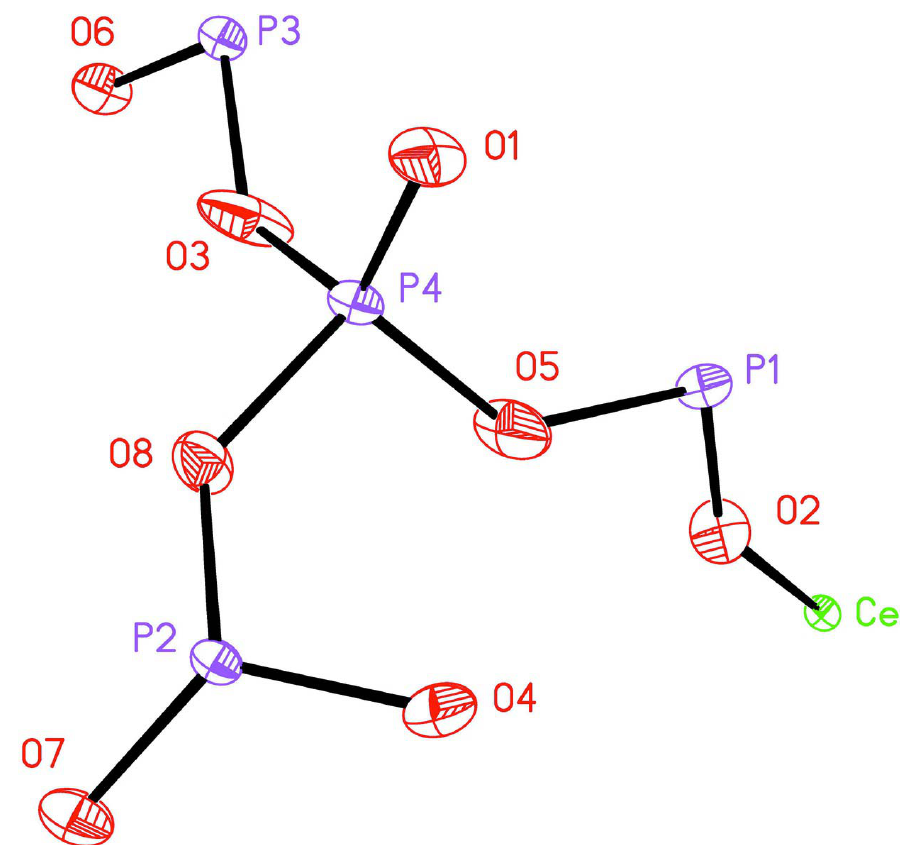
Figure 1 Asymmetric unit with displacement ellipsoids shown at 50%